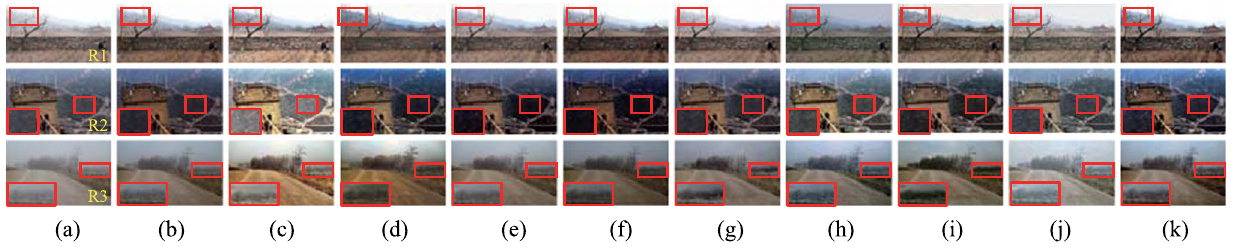
Fig. 8 SZDNet and well-known methods were compared qualitatively on the real shot images. a Hazy images. b DCP [18]. c IDE [33]. d